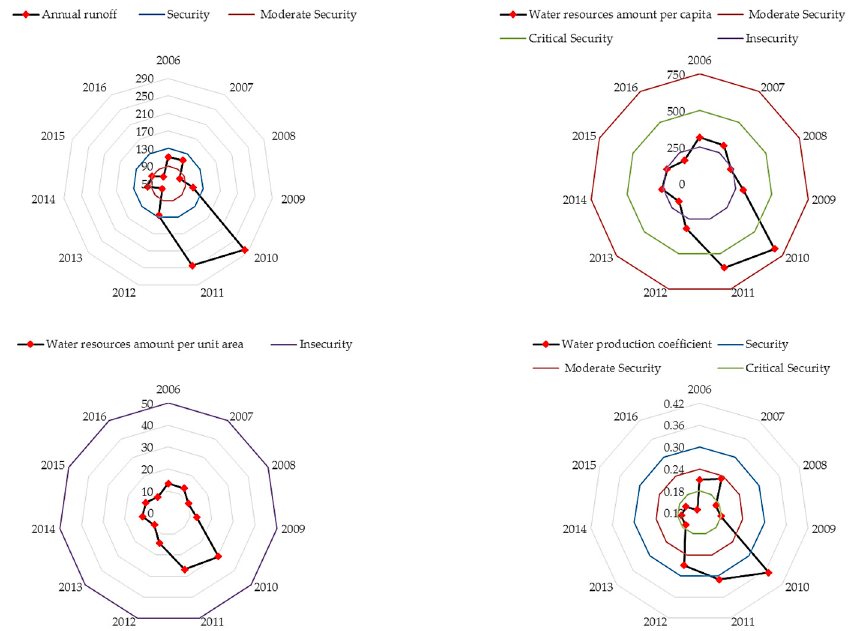
Figure 8. Change of indexes in state subsystem from 2006 to 2016. Water 2018 , 10 , x FOR PEER REVIEW